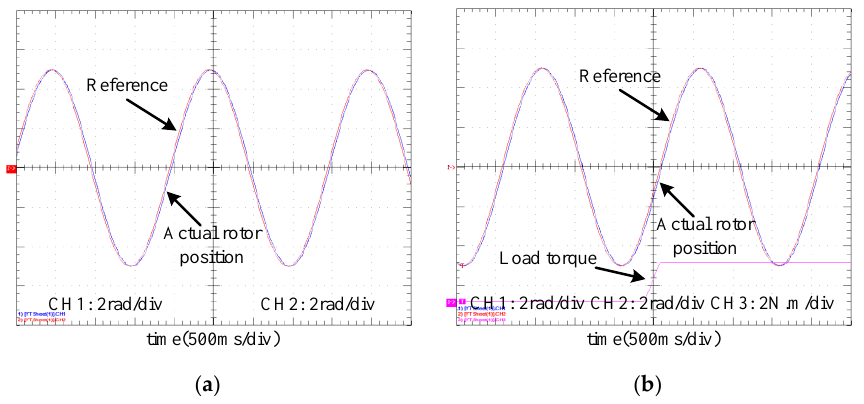
Figure 14. Rotor position and reference experimental results of the NMPSC with the proposed method. ( a ) Steady-state; ( b ) Transient state.